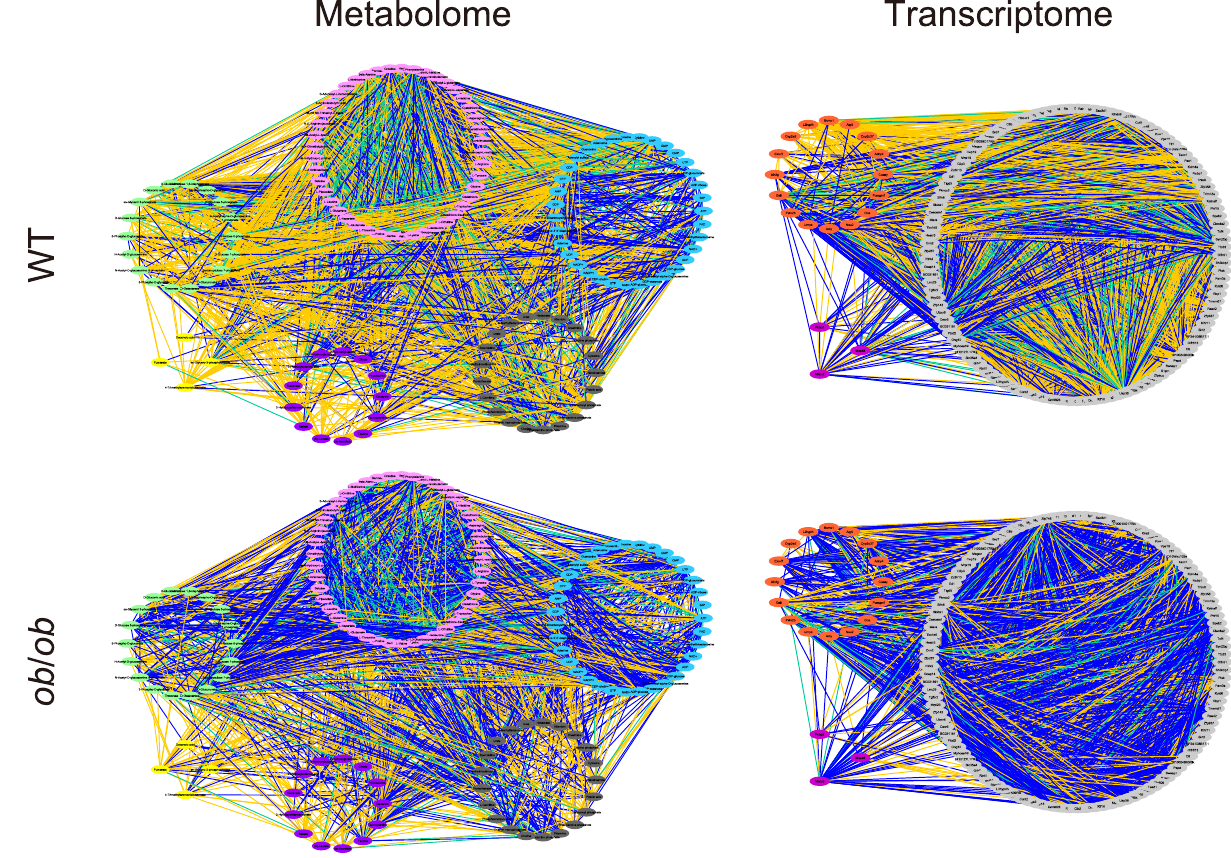
Figure 2. The OGTT response network. The OGTT response network of the metabolome (left column) and transcriptome (right column) in WT (upper row) and ob / ob (lower row). All of the 136 metabolites and the 136 genes randomly extracted from the 12,415 genes used for analysis were visualized. The blue, yellow, and green edge represents the edge that existed only in the OGTT (0) network, only in the OGTT (4) network, and that are common to both the networks,